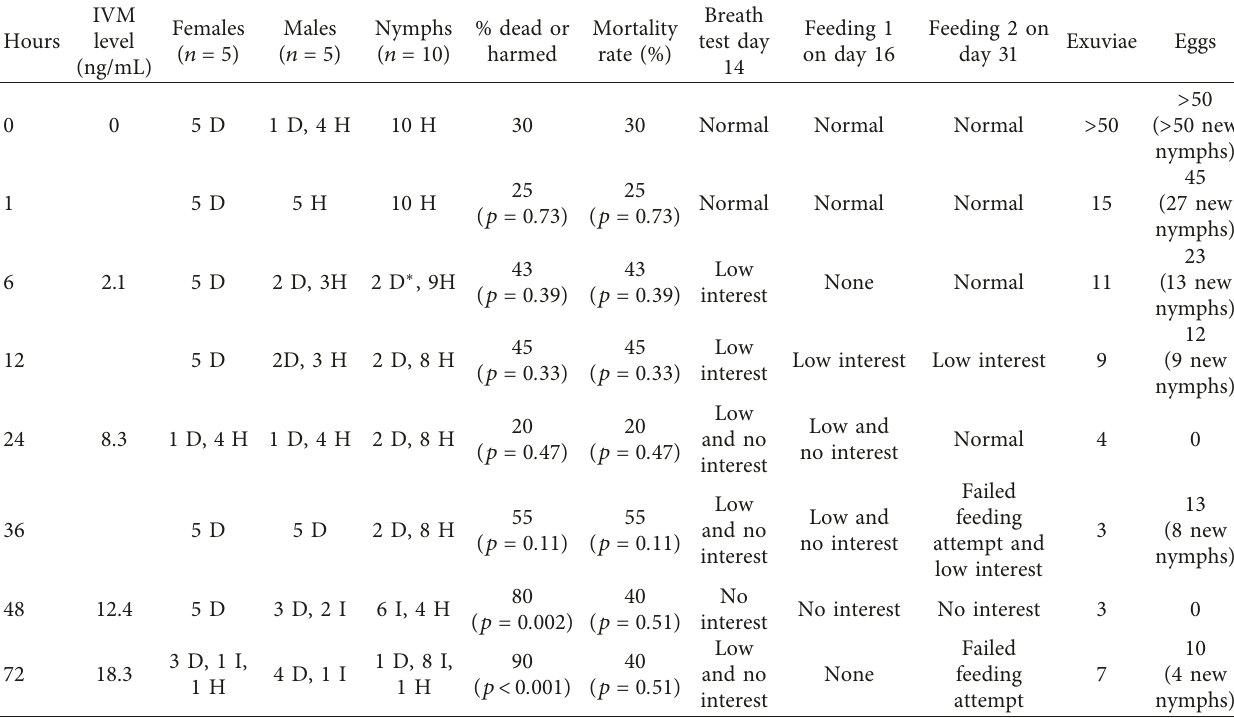
Table 2: Test 2 data with each life stage recorded as dead (D), incapacitated (I), or healthy (H) at day 64 after feeding. Also recorded are the breath test, feeding 1 test, feeding 2 test, exuviae, and eggs at day 64 for each group fed hours (Hr) after ivermectin